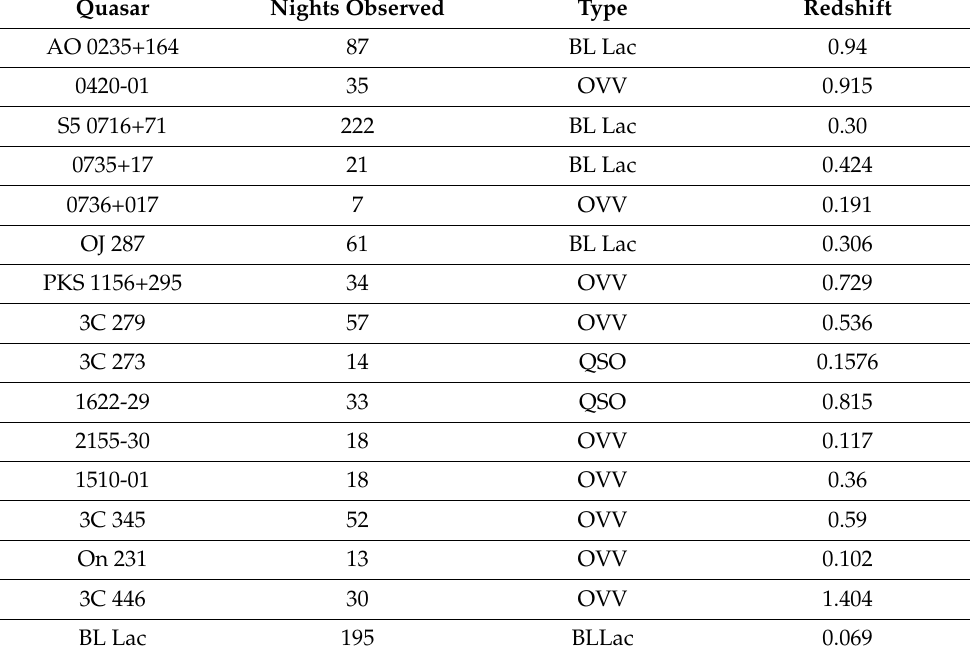
Table 2. SARA-FIU observing